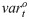
The blue and red points represents the samples from target and background regions, and two different sets are selected by the traditional (upper) and proposed (lower) models.In the previous classification methods, the classification margin is defined by maximizing the minimum interclass distance (in this figure, the distance between the red and blue points). In the definition of optimal model, the sample distribution (varto, vartb and valt) is considered. In comparison, the target and background sample sets selected by the proposed optimal model are of better discrimination, as shown in this figure.